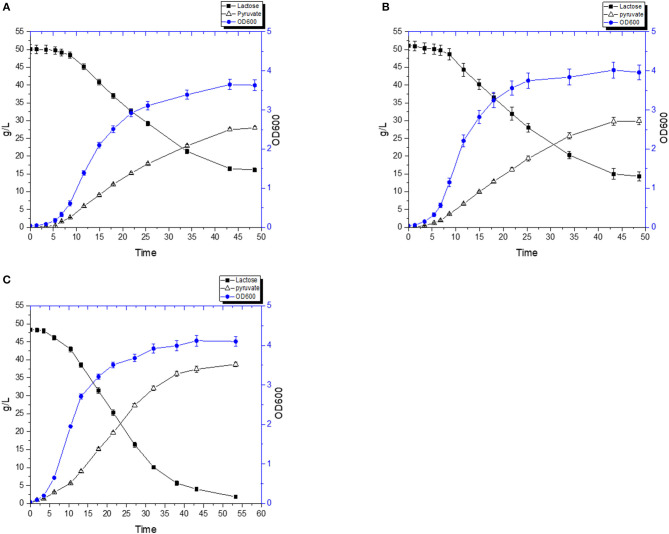
Pyruvate production with 0.5% Yeast extract. The recombinant strain FS1080 was grown in the diluted whey with 0.5% yeast extract. (A) 0 μg/mL hemin, (B) 1 μg/mL hemin, (C) 1 μg/mL hemin with 2 μg/L CoCl2.6H2O with 2 μg/L MnSO4.H2O. Measurements are the average value ± standard error from independent duplicate cultivations.